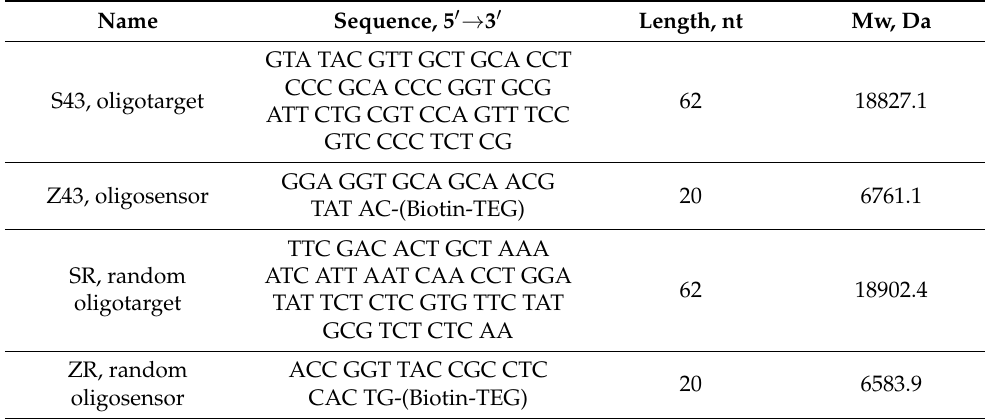
Table 1. Sequences of oligonucleotides used in the